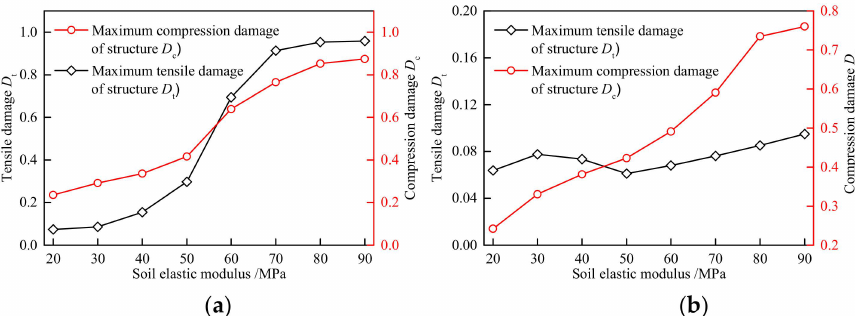
Figure 17. Effect of the elastic modulus of stratum on the structural damage of the segments: ( a ) normal faulting condition and ( b ) reverse faulting